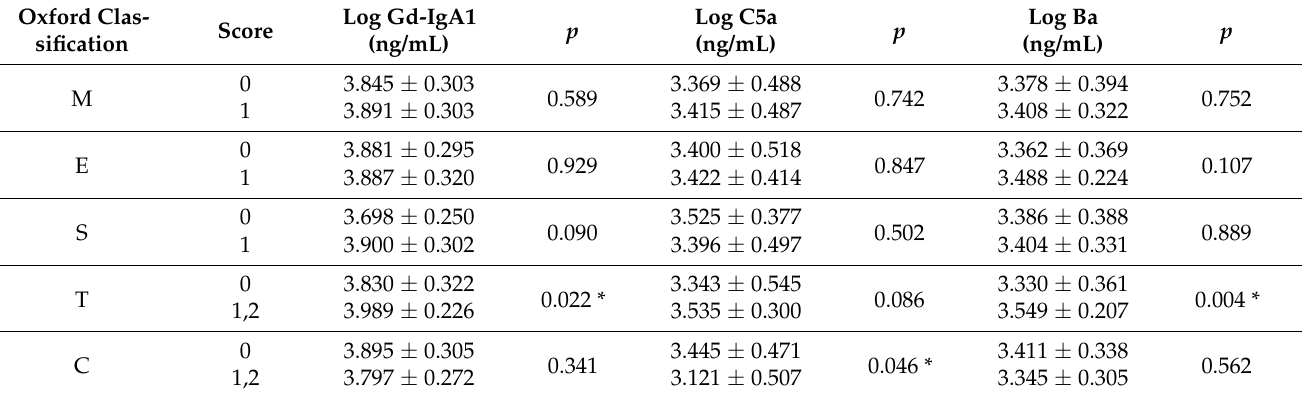
Table 3. Comparisons of biomarker levels between the groups stratified according to the Oxford classification of MEST-C histopathology.